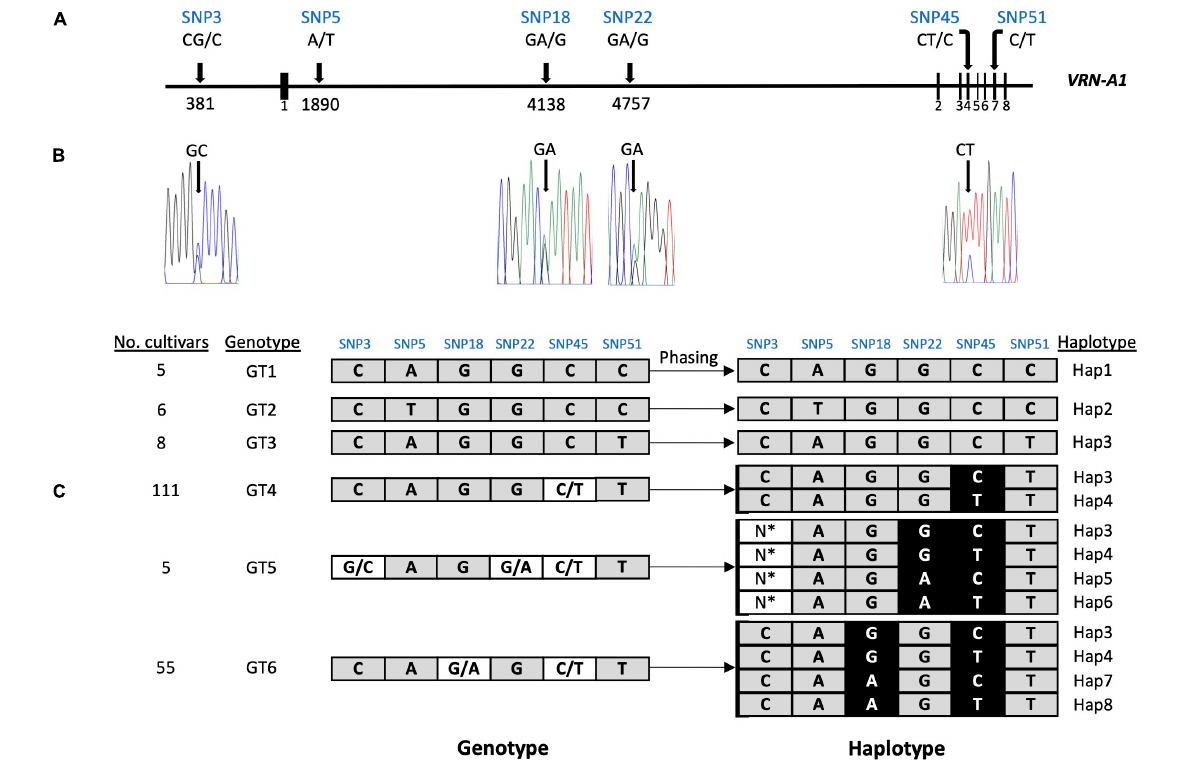
FIGURE 3 | Phasing of the VRN-A1 haplotypes using ONT long reads. (A) scheme shows the location of six SNPs in VRN-A1 . (B) Four SNPs with overlapping peaks were detected in Sanger sequencing chromatograms. (C) Haplotypes were deduced from genotypes using ONT long reads. ∗ Due to the SNP3 location between Gs, Cs repeats region and the presence of many indels in this region, it was difficult to identify the allele accurately from ONT reads.